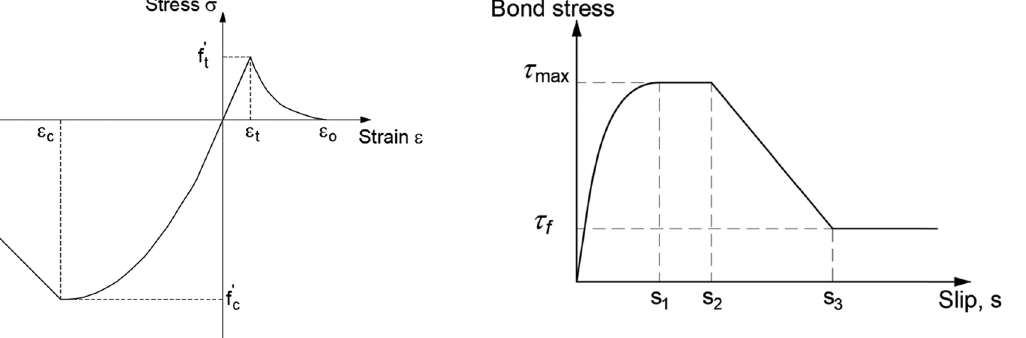
Figure 14: Stress – strain relationship for concrete.